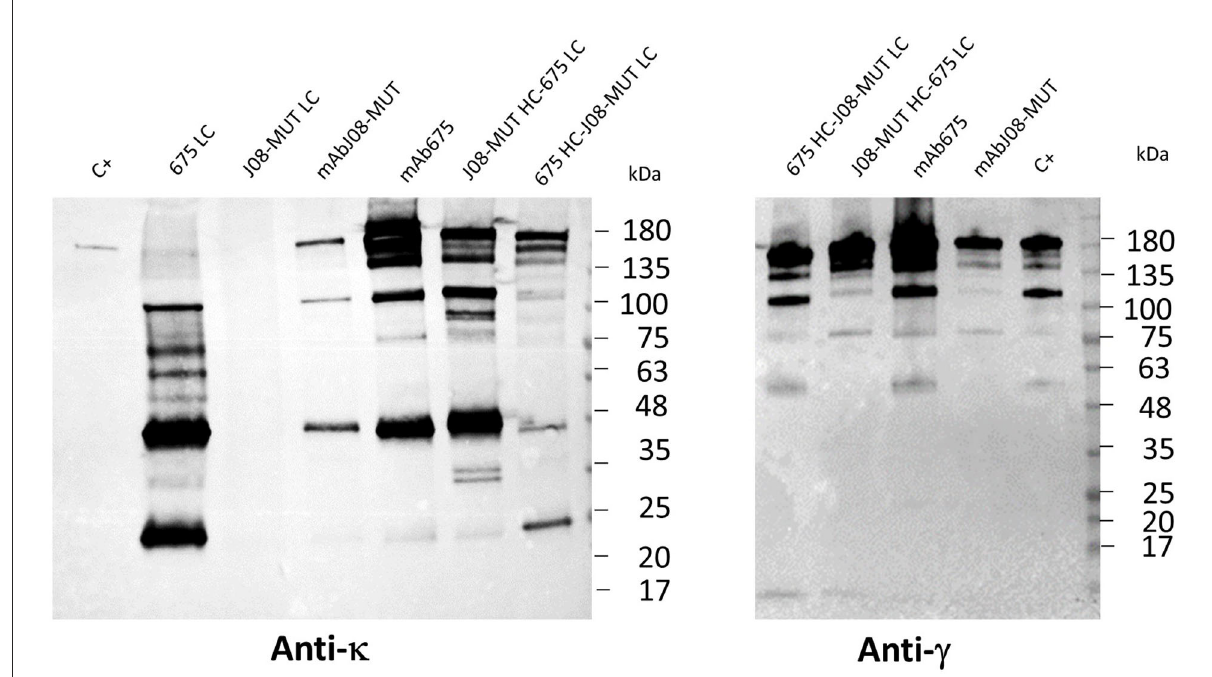
FIGURE3 Effect of LC expression levels on the accumulation of antibodies. Western blot analysis of leaves agroinfiltrated with single LCs of mAbJ08-MUT and mAb675 or with HC and LC combinations of the two nAbs (J08-MUT-HC-675 LC and 675 HC-J08-MUT LC). Agroinfiltrated leaves were collected on day 6 post-infiltration. Extracts normalized for total soluble protein (TSP) content were separated on non-reducing (NR) 12% SDS-PAGE; 15 µ g of TSP was loaded for assembled antibody samples, while 45 µ g of TSP was loaded for the two 675 LC and J08-MUT-LC samples. C + : 50 ng of purified human IgG1 mAbRTX. Detection was performed with an anti-human γ chain (HC) or anti-human κ chain (LC) HRP-conjugated